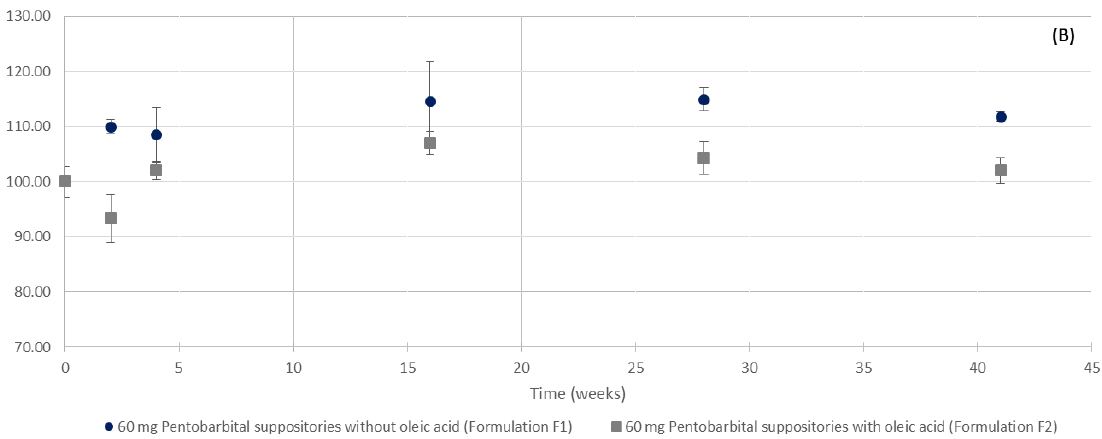
Figure 4. Evolution of the pentobarbital quantities of ( A ) 30 mg and ( B ) 60 mg suppositories with and without oleic acid. n = 5, mean ± 95% confidence interval.